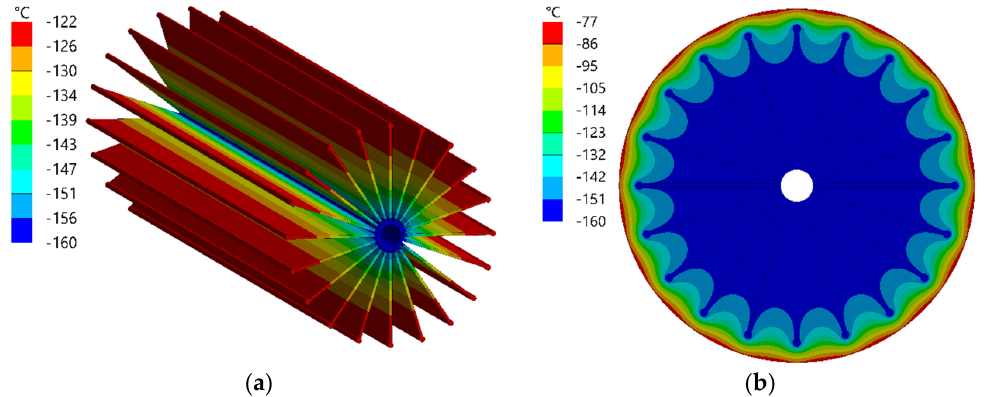
Figure 13. Temperature distribution: ( a ) 20 fins—no frost, ( b ) 20 fins with frost.